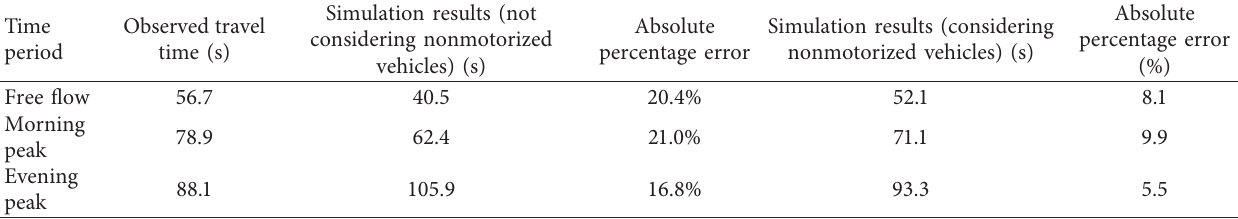
Table 10: Comparison of vehicle travel times in three periods.